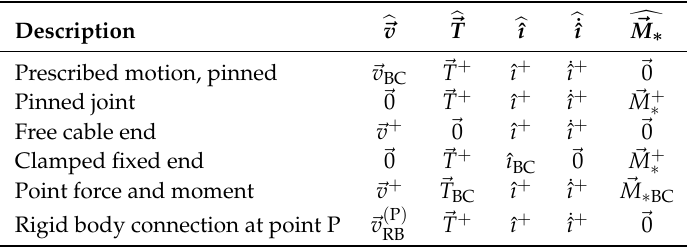
Table 1. Table of fluxes required for different typical connections used in a mooring system. Index BC indicates a prescribed value at the boundary, and "+" indicates a value taken from the internal